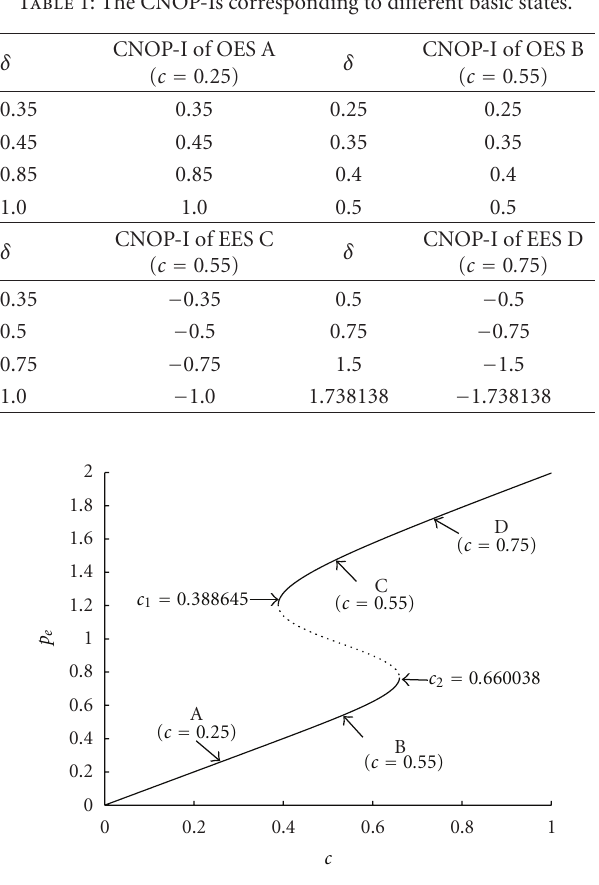
Figure 1: The equilibrium states versus the nutrient loading rate c , where c 1 and c 2 are the bifurcation points, the solid line refers to the linearly stable equilibrium states and the dashed line refers to the linearly unstable equilibrium